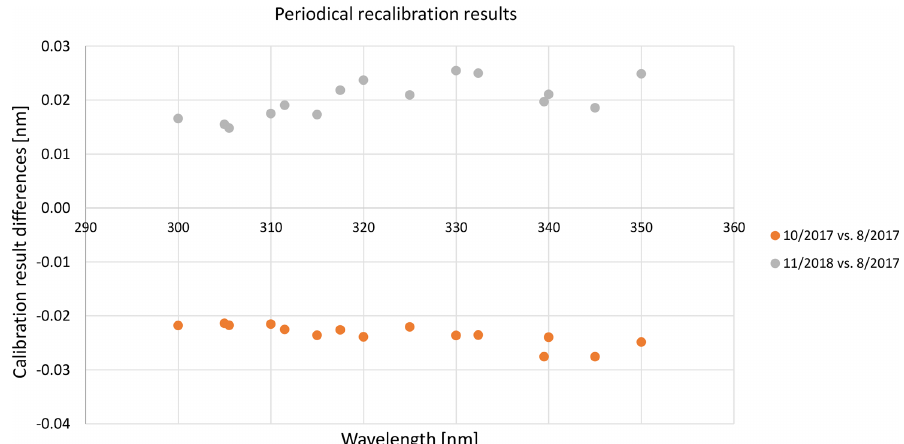
Figure 11. The largest differences measured in pre- and post-campaign TuPS wavelength-scale calibrations in CMI. Dobson comparison campaign in AEMET Izaña in Spain (orange circles) and campaign in the Deutscher Wetterdienst (DWD) in Hohenpeissenberg in Germany (grey